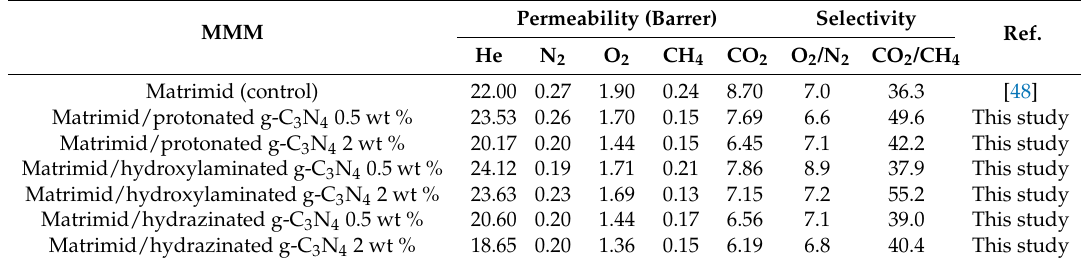
Table 2. Permeabilities/selectivities of the Matrimid/g-C 3 N 4 MMMs for He, N 2 , O 2 , CH 4 , CO 2 , O 2 /N 2 , and CO 2 /CH 4 as a function of different filler treatments at different doping levels (0.5 wt % and 2 wt